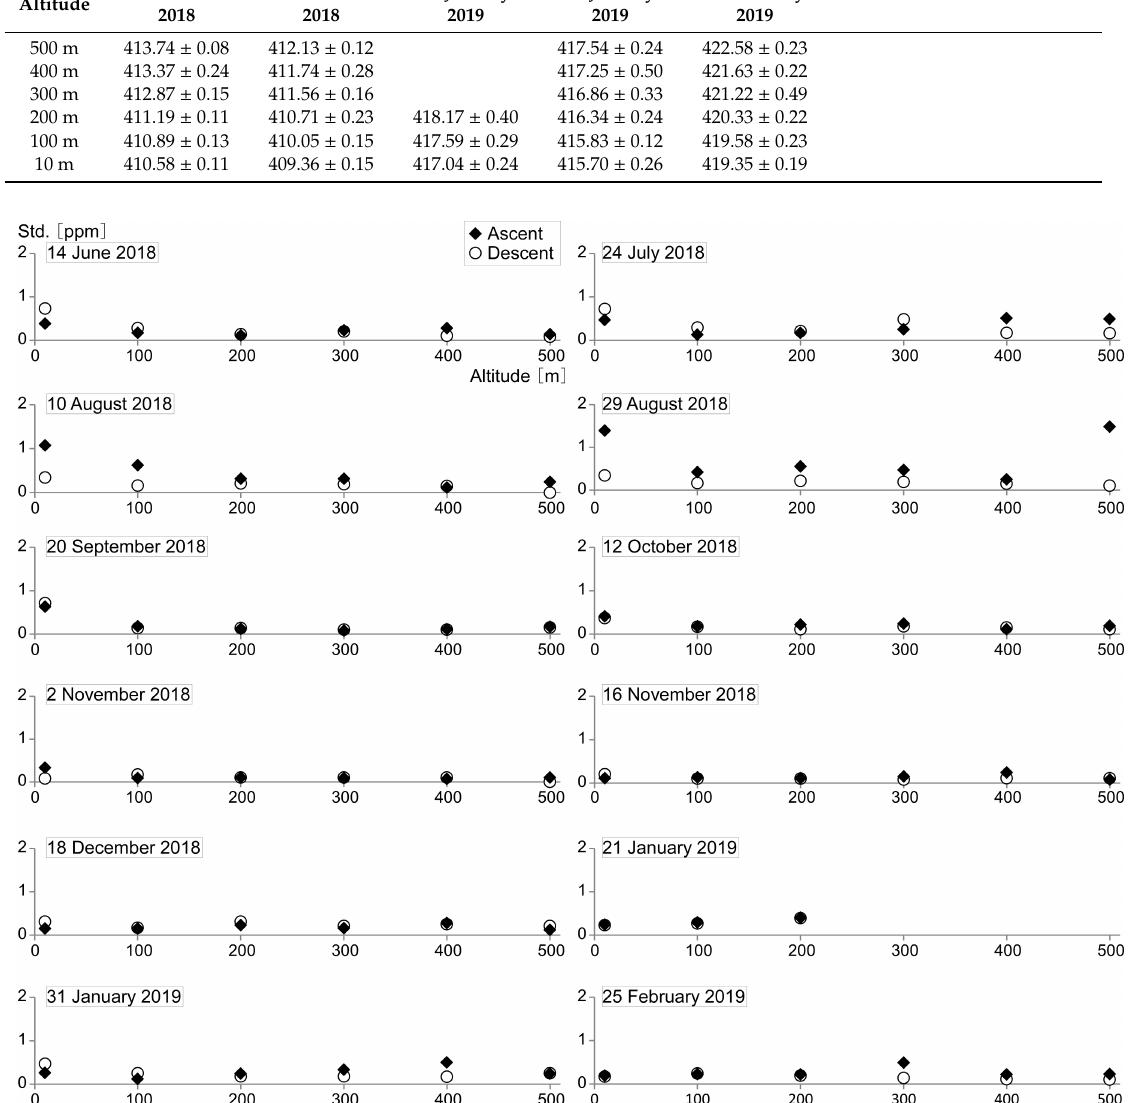
Figure A1. Comparison of CO 2 concentrations measured during the UAV’s descent (Table A3) with those measured during its ascent (Table A4). Table A5. Major specifications of the Lithium-ion battery.